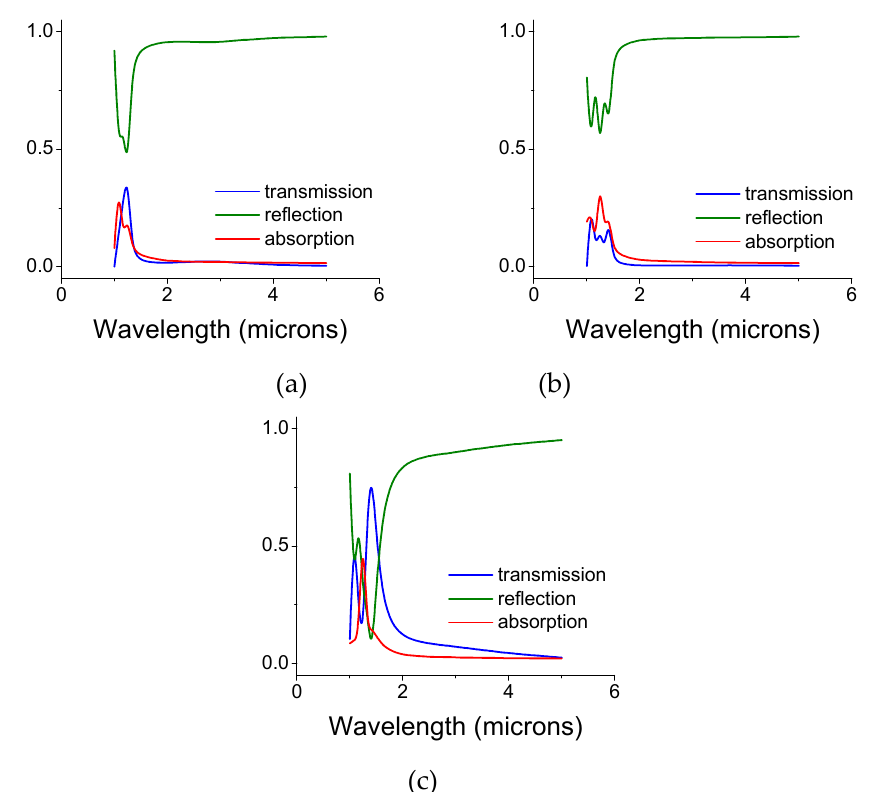
Figure 3. Intensity coefficients, transmission, reflection, and absorption for an un-shifted bi-layer screen whose air gap is filled with silica colloids. The opening and disk diameters are 0.5 and 0.7 microns, respectively. ( a ) The gap is 0.25 microns. ( b ) The gap is 0.5 microns. ( c ) The opening and disk diameters are interchanged: 0.7 and 0.5 microns, respectively, for a gap of 0.5 microns. The thickness of each copper mono-screen is 0.1 microns and the diameter of the colloids equals the gap size.